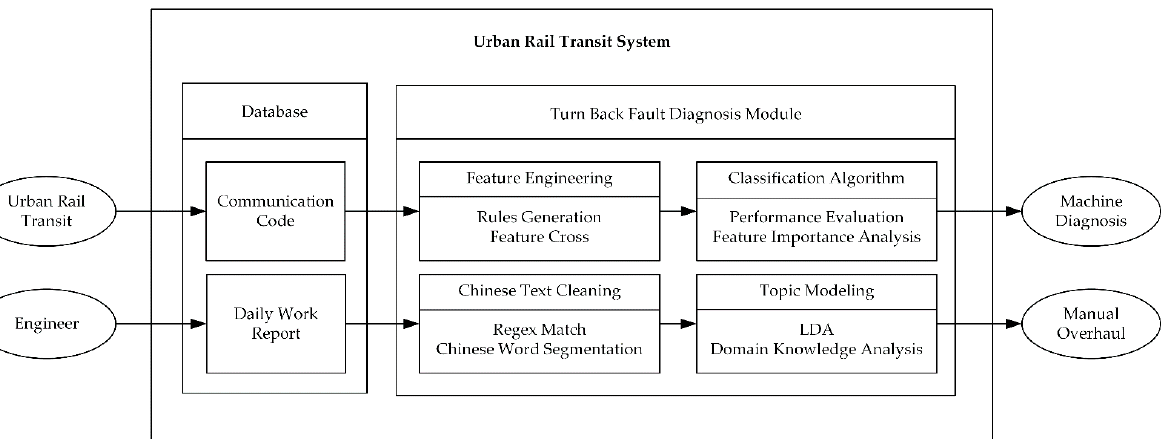
Figure 4. General framework.